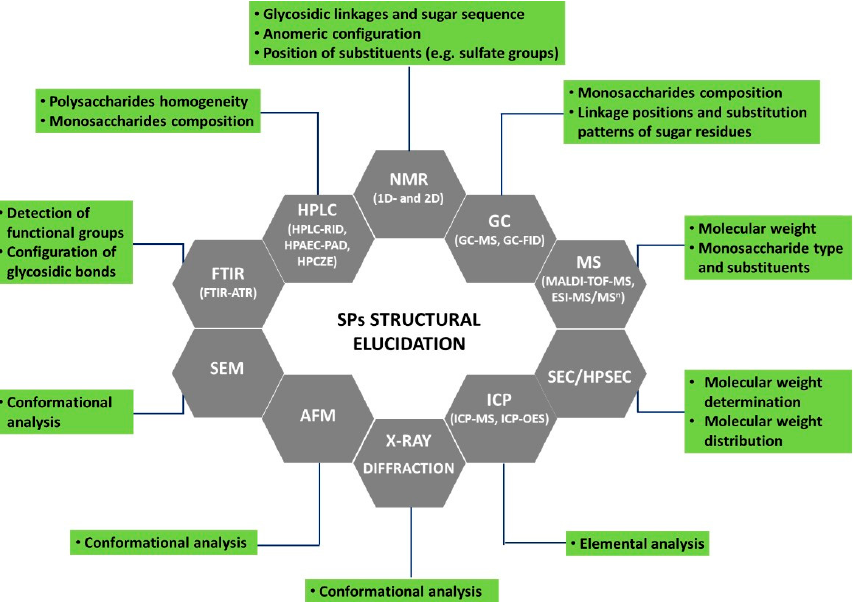
Figure 3. Current techniques for macroalgae sulfated polysaccharides’ structural characterization.